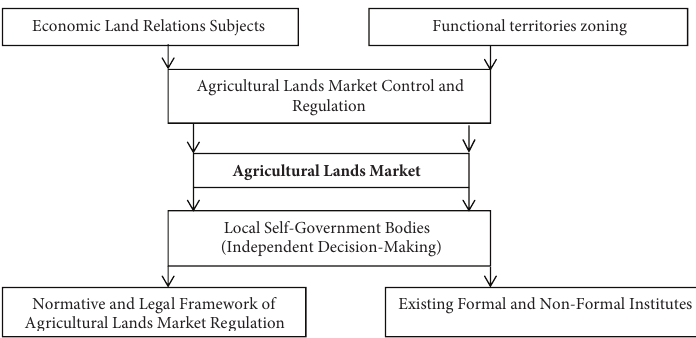
Figure 1. The structural and logical scheme of effective functioning of the agricultural lands